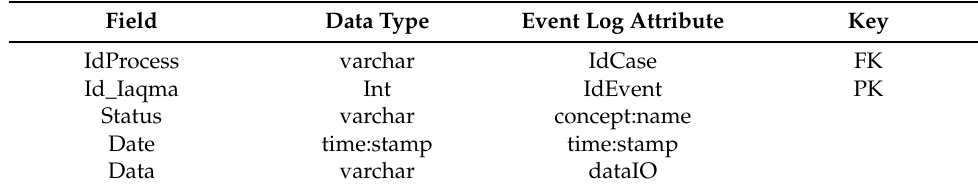
Table 1. Mapping between the columns associated with the IoT_AirQuality_Monitor_Access table and the event log